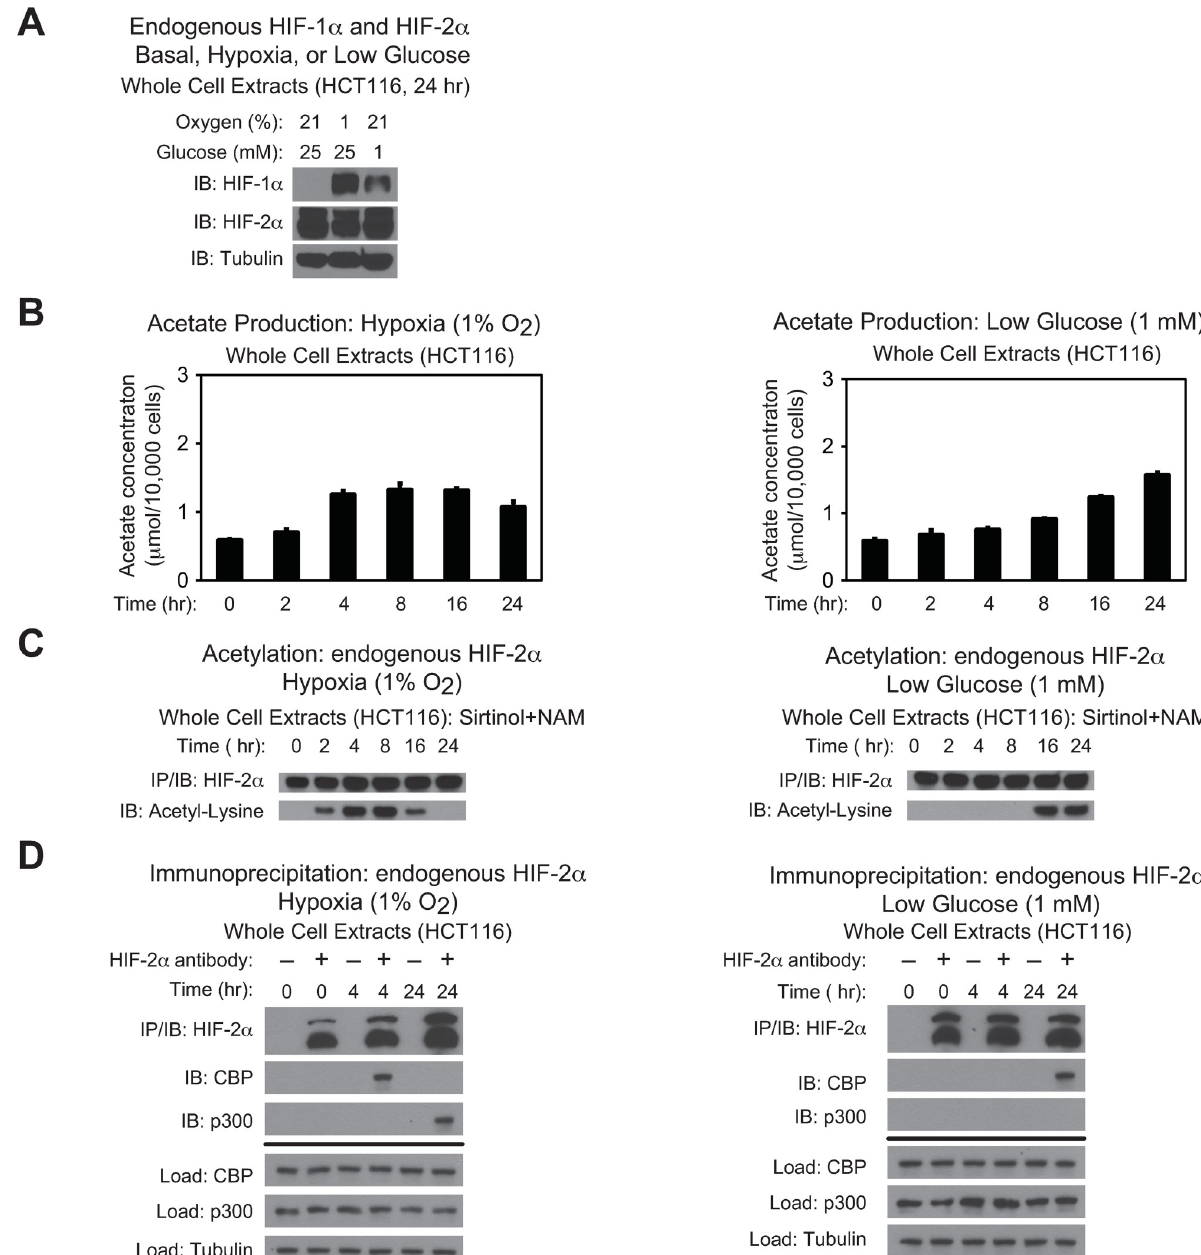
Fig 1. Stress induces CBP/HIF-2 α interactions in HCT116 cells. (A) Detection of endogenous HIF-1 α or HIF-2 α in HCT116 whole cell extracts by immunoblotting after the indicated period of hypoxia exposure or glucose deprivation. Alpha-tubulin levels for each immunoblot are also shown. (B) Cellular acetate levels generated in HCT116 cells after the indicated period of hypoxia exposure (left side) or glucose deprivation (right side) ( n = 3 biological replicates/time-point; single measurement/replicate; mean/SD) differed as a function of time (P < 0.001, one-way ANOVA). (C) Acetylation of endogenous HIF-2 α in HCT116 cells after immunoprecipitation (IP) and detection by immunoblotting (IB) after the indicated period of hypoxia exposure (left side) or glucose deprivation (right side) with pharmacological inhibition of Sirt1 by sirtinol and nicotinamide (NAM). (D) Detection of endogenous CBP/HIF-2 α or p300/HIF-2 α complexes in HCT116 cells by immunoblotting (IB) after early (4 hr) and late (16 hr) hypoxia exposure (left side), or after early (2 hr) and late (24 hr) low glucose exposure (right side).